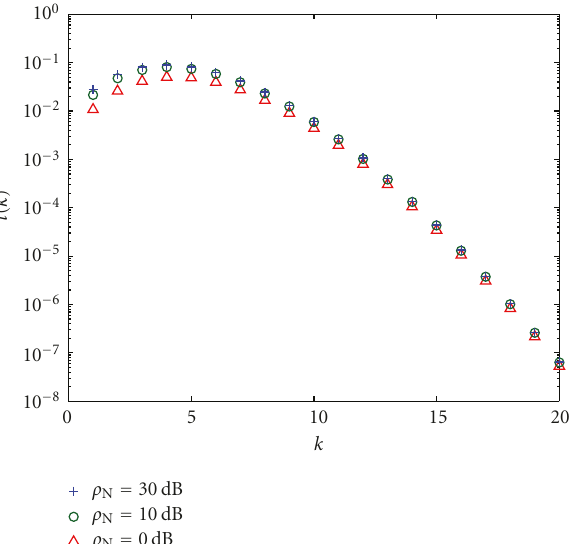
Figure 1: Evaluation of t ( k ) in (12) when ρ I = 10 d B.